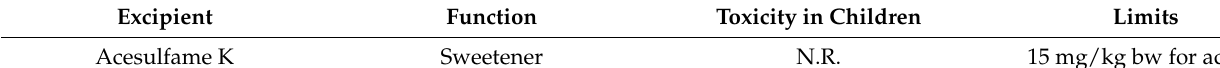
Table 1. Tolerance limits of the main excipients as currently proposed by the EuPFI